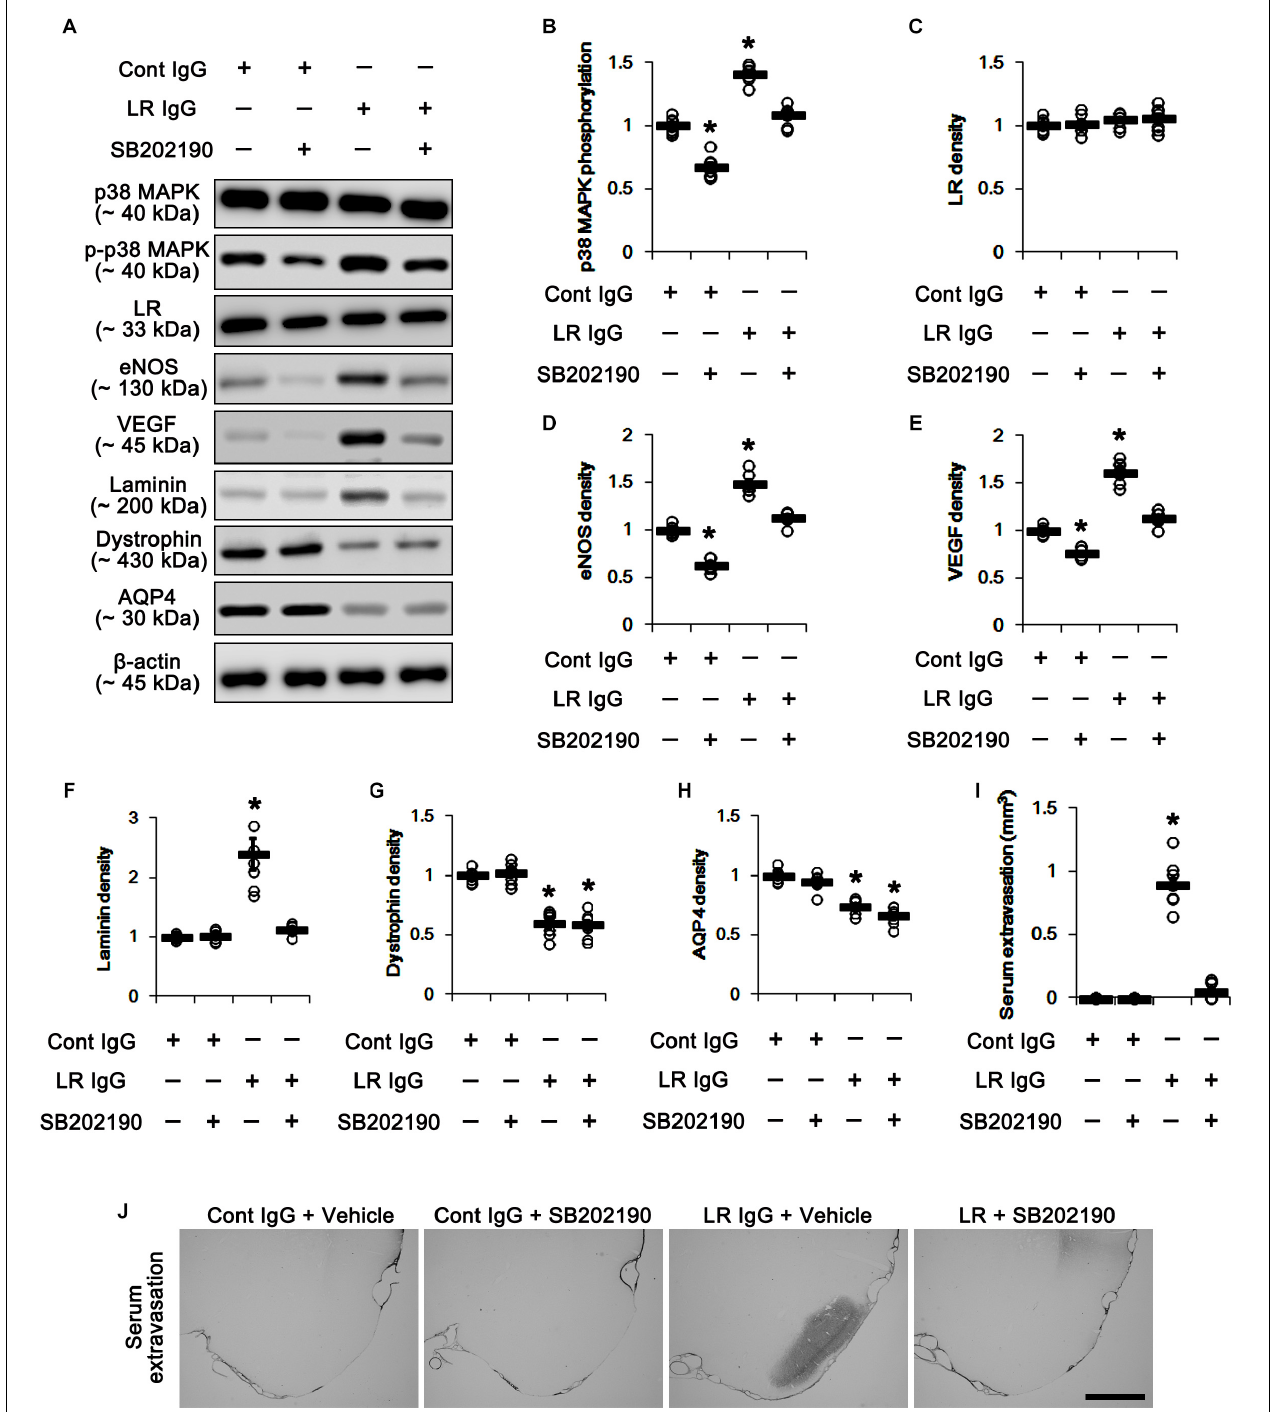
FIGURE 5 | Effect of 67-kDa LR (LR) neutralization and SB202190 co-treatment on serum extravasation in the PC of normal animals. (A) Western blot image for expression levels of p38 MAPK, phospho (p)-p38 MAPK, 67-kDa LR, eNOS, VEGF, laminin, dystrophin, and AQP4. (B–H) Quantitative values (mean ± S.E.M) of the Western blot data concerning expression levels of phospho (p)-p38 MAPK, 67-kDa LR, eNOS, VEGF, laminin, dystrophin, and AQP4 ( n = 7, respectively). Open circles indicate each individual value. Horizontal bars indicate mean value. Significant differences are ∗ p < 0.05 vs. control IgG (one-way ANOVA). (I,J) Quantitative values (mean ± S.E.M) of areas ( n = 7, respectively; (I) and representative photographs (J) of serum extravasation in the PC. ∗ p < 0.05 vs. control IgG (one-way ANOVA). Bar = 400 µ m.